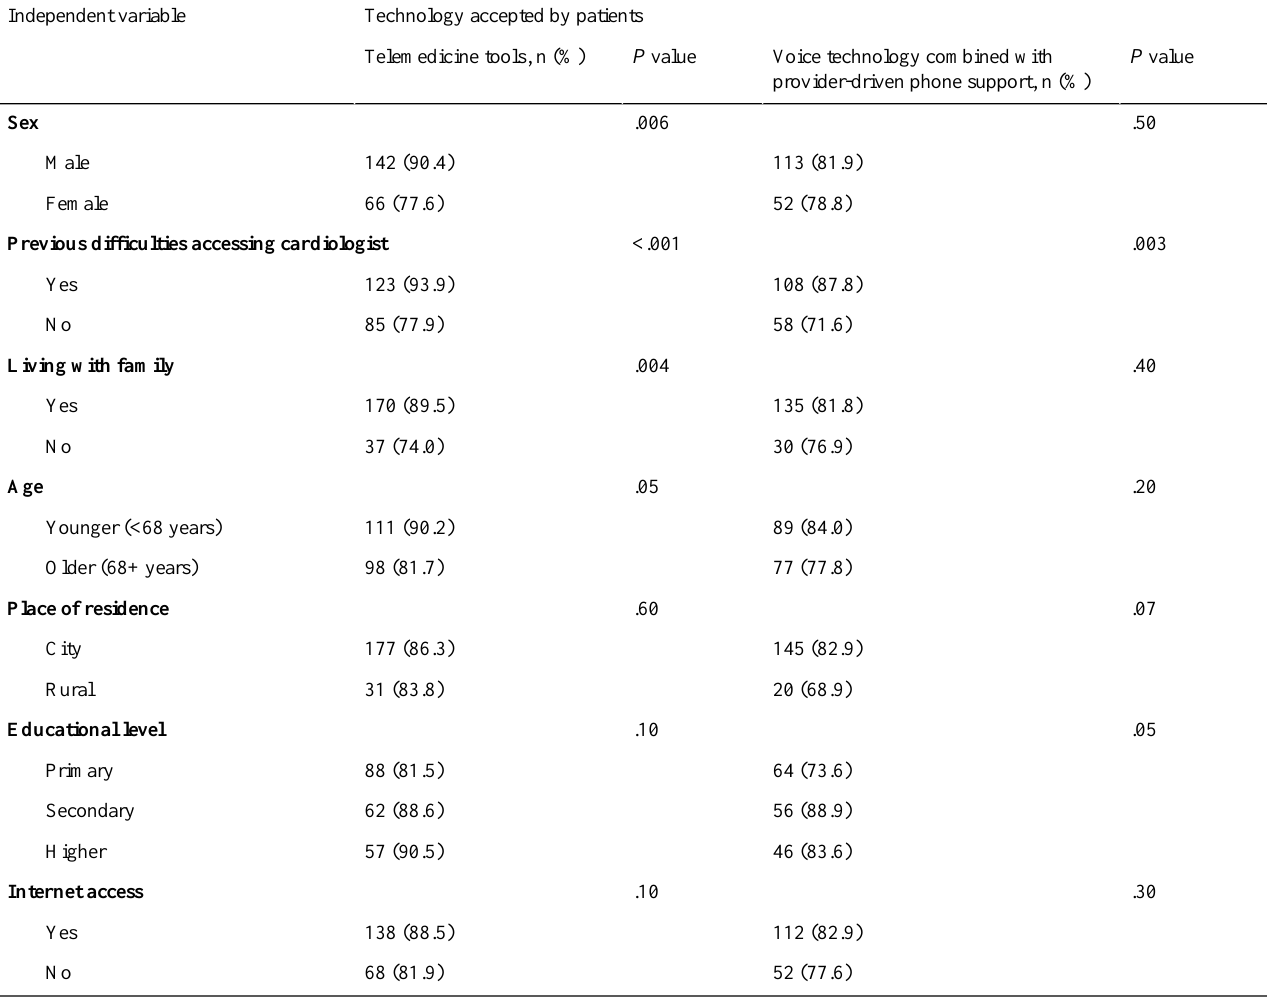
Table 3. Factors influencing patients' acceptance of